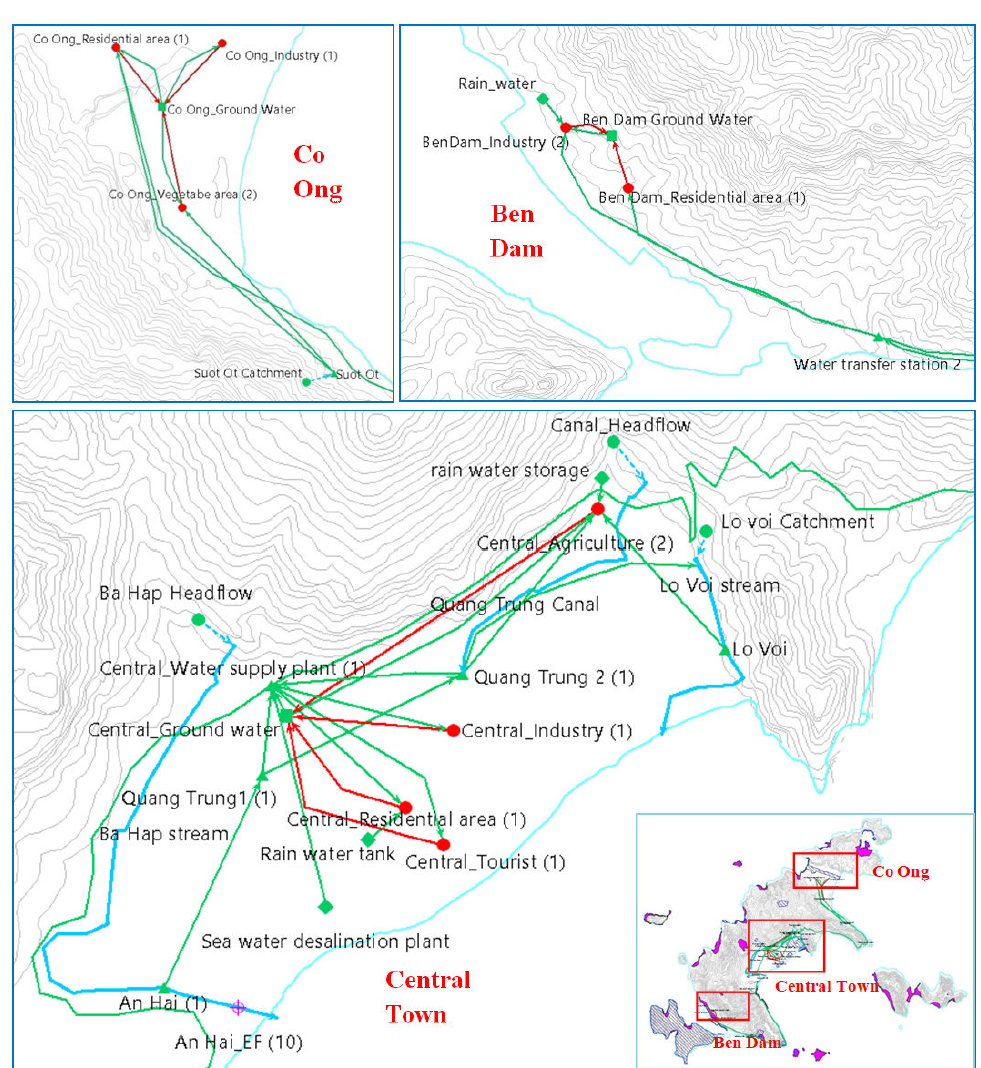
Figure 5. Schematic of the WEAP model for Con Dao